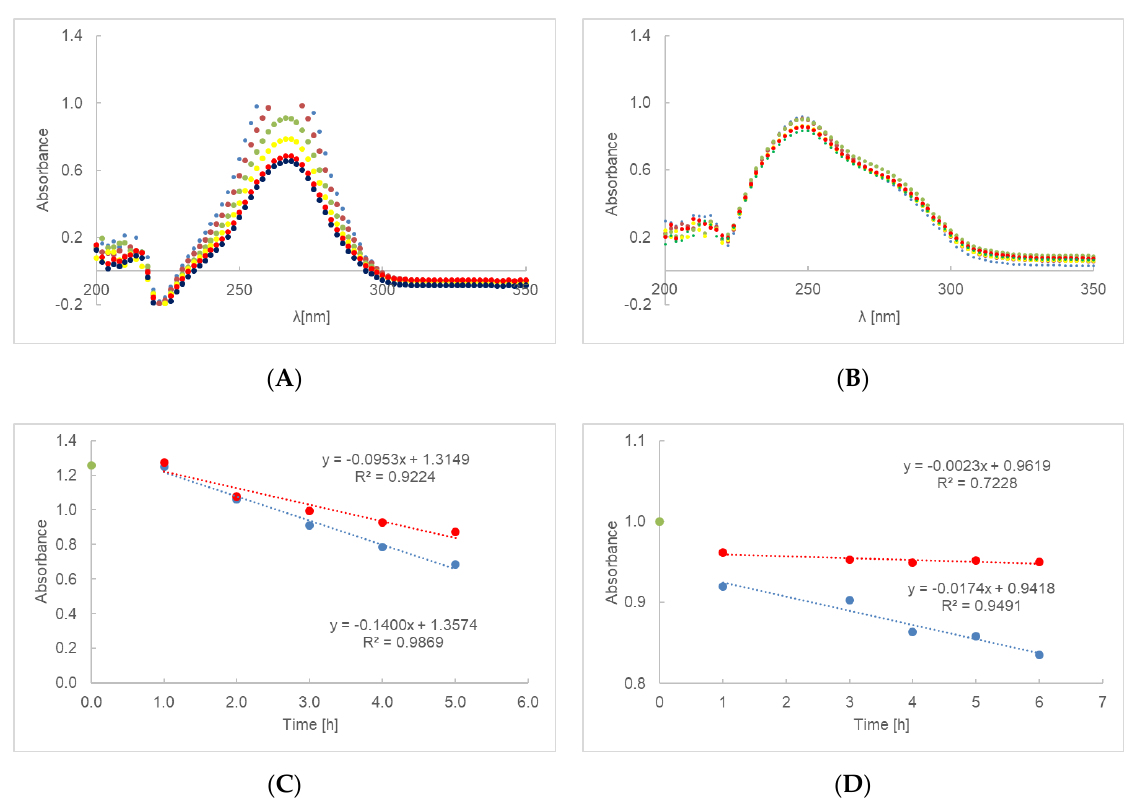
Figure 2. UV-Vis spectra of preparation AA-PA-G ( A ) and AE-PA-G ( B ), irradiated at 0( – ), 1( – ),2( – ), 3( – ), 4( – ), 5( – ) and 6( – ) h. The UV degradation gel containing PA and ascorbic acid ( C ), or ethyl ascorbic acid ( D ), presented as time function of absorbance. Red dots represent unexposed samples and blue dots represent irradiated samples. During the first hour, the specimen stabilizes — the green dot represents the starting point of the procedure on ( D ) graph.